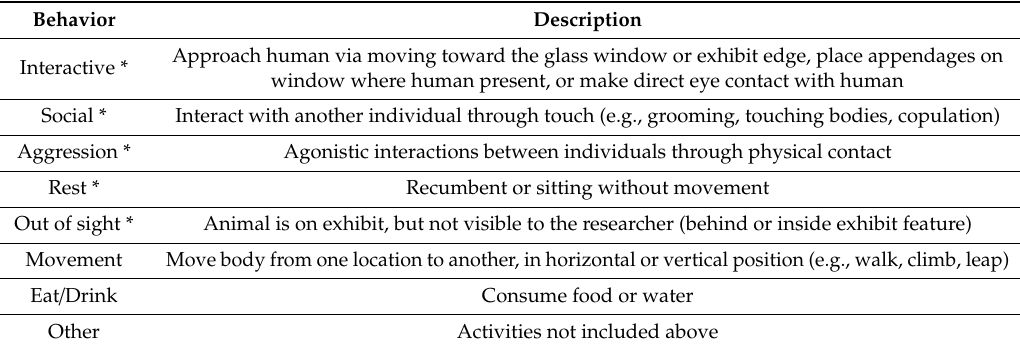
Table A6. Primate ethogram, with behaviors of focus indicated with an asterisk